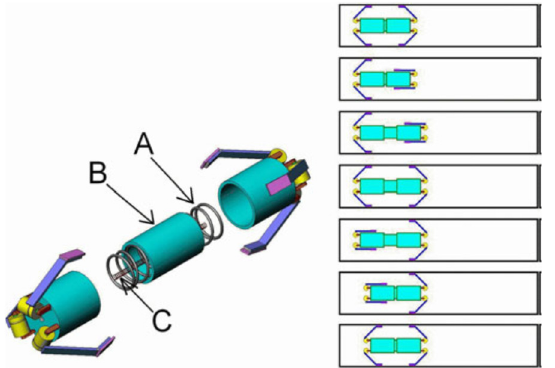
Figure 3. Illustration of inchworm-like locomotion mechanism. ( A ) compression spring; ( B ) capsule body; ( C ) SMA wire. Adapted from Liu et al. [25] with permission from IEEE. body; ( C ) SMA wire. Adapted from Liu et al. [25] with permission from